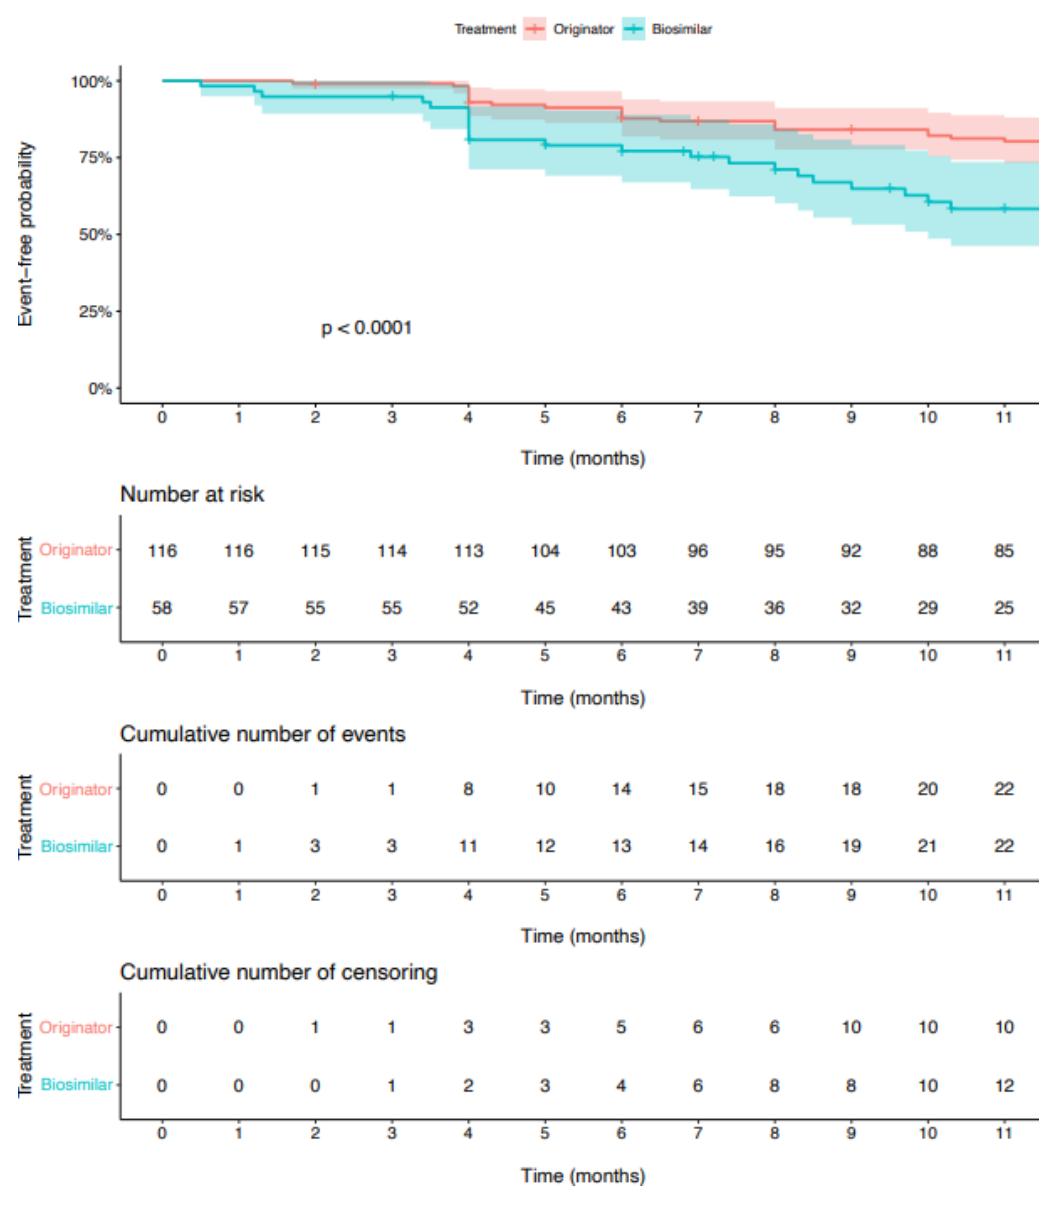
Figure 2. Time to ineffective treatment by treatment group.